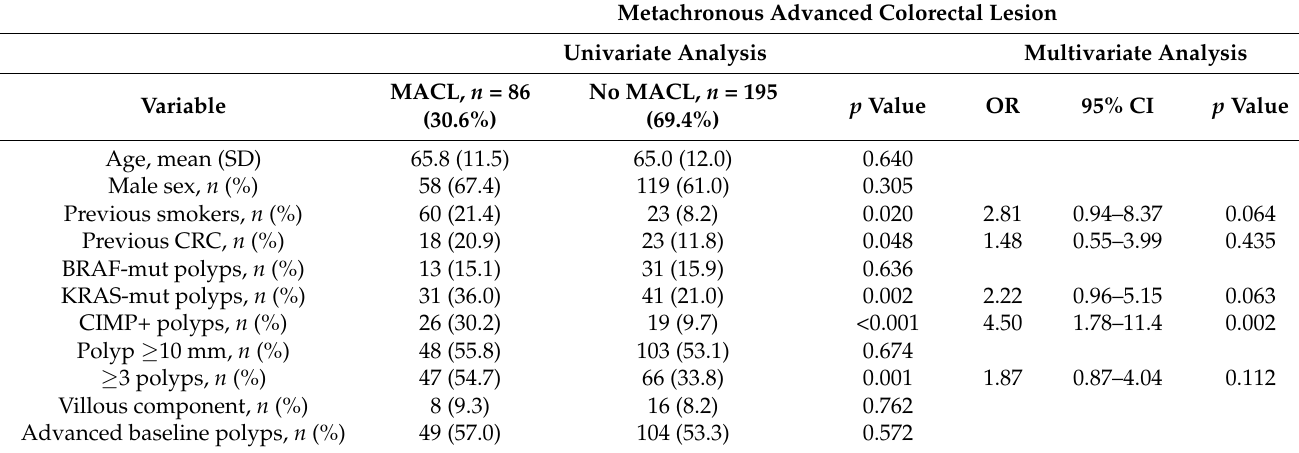
Table 3. Risk factors for metachronous advanced colorectal lesion (MACL).